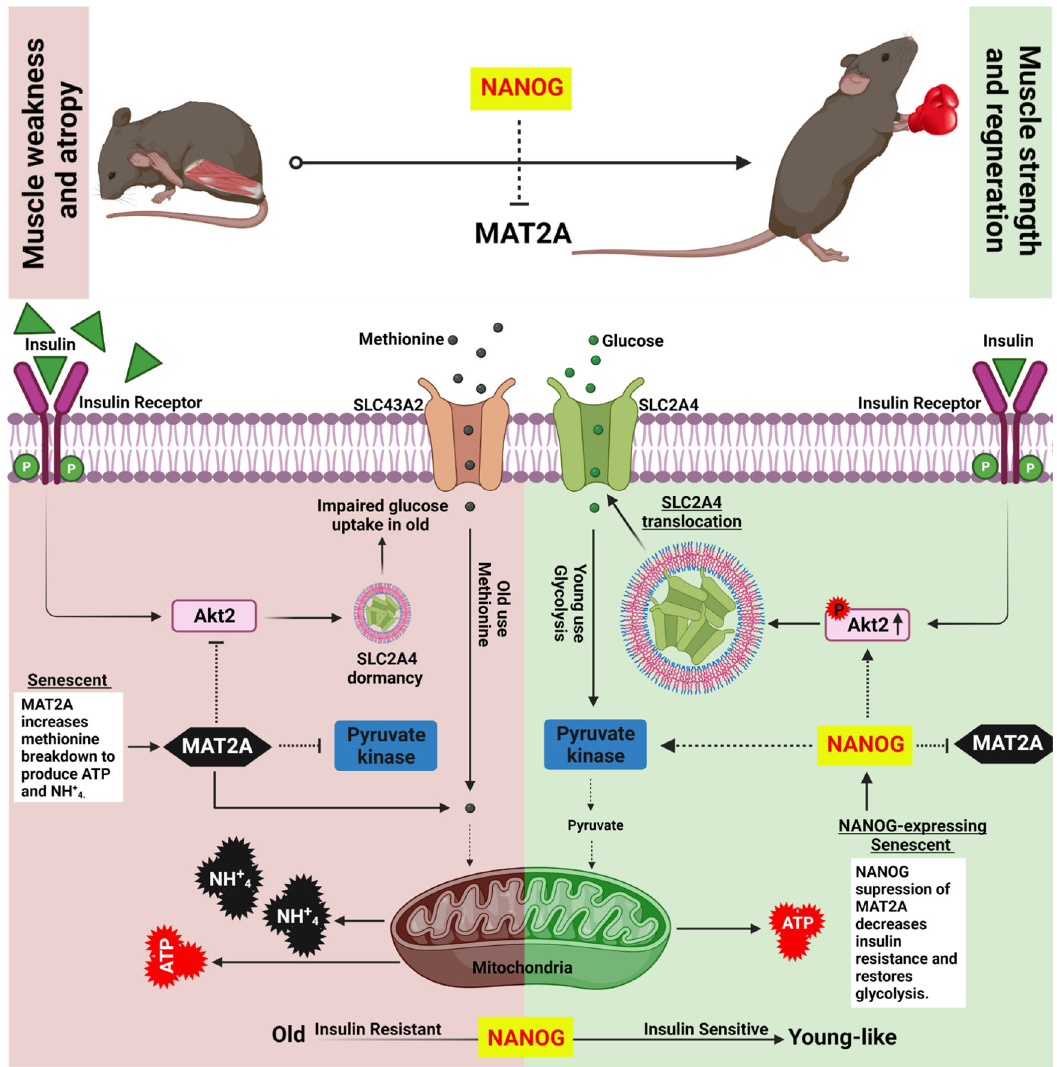
Fig. 10 | Schematic of the metabolic and signaling pathways affected in senescentorprogeriamyoblastsandreversedbyNANOGorMAT2Ainhibition. Both insulin resistance and Akt2 inactivation prevent GLUT4 translocation and inhibit glucose usage for energy production. In response, bioenergetics is